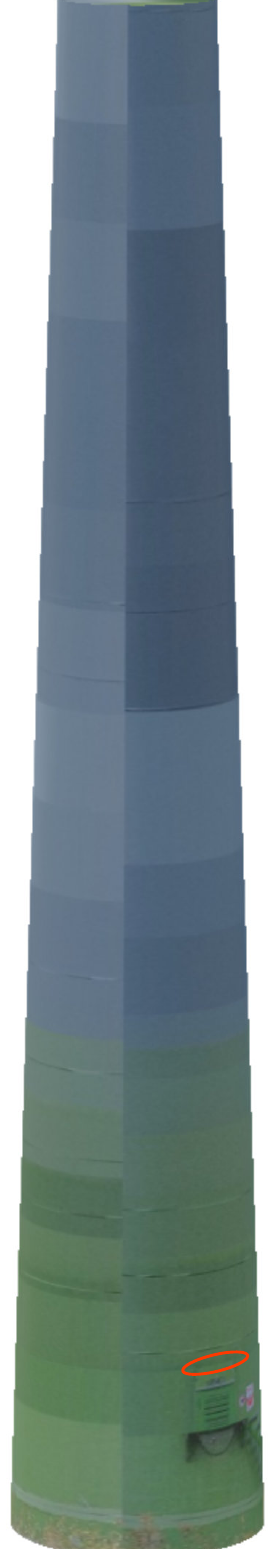
Figure 4. Texture for the 3D model of a wind turbine based on the dataset described in Section 2. The red ellipse highlights an example